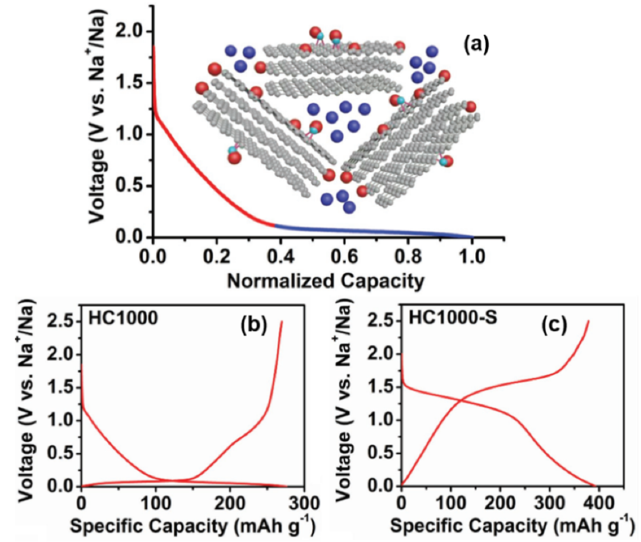
Figure 7. ( a ) Schematic illustration of the “adsorption-pore filling “mechanism for Sodium-ion storage in HC. ( b ) Galvanostatic charge and discharge curves in the 2 nd cycle of 1000 °C pyrolytic HC. ( c ) Galvanostatic charge and discharge curves in the second cycle of 1000 °C pyrolytic HC–S composite.(in Na half-cells with 0.8M NaPF 6 in DEGDME at a current density of 20 mA g −1 ) [66].